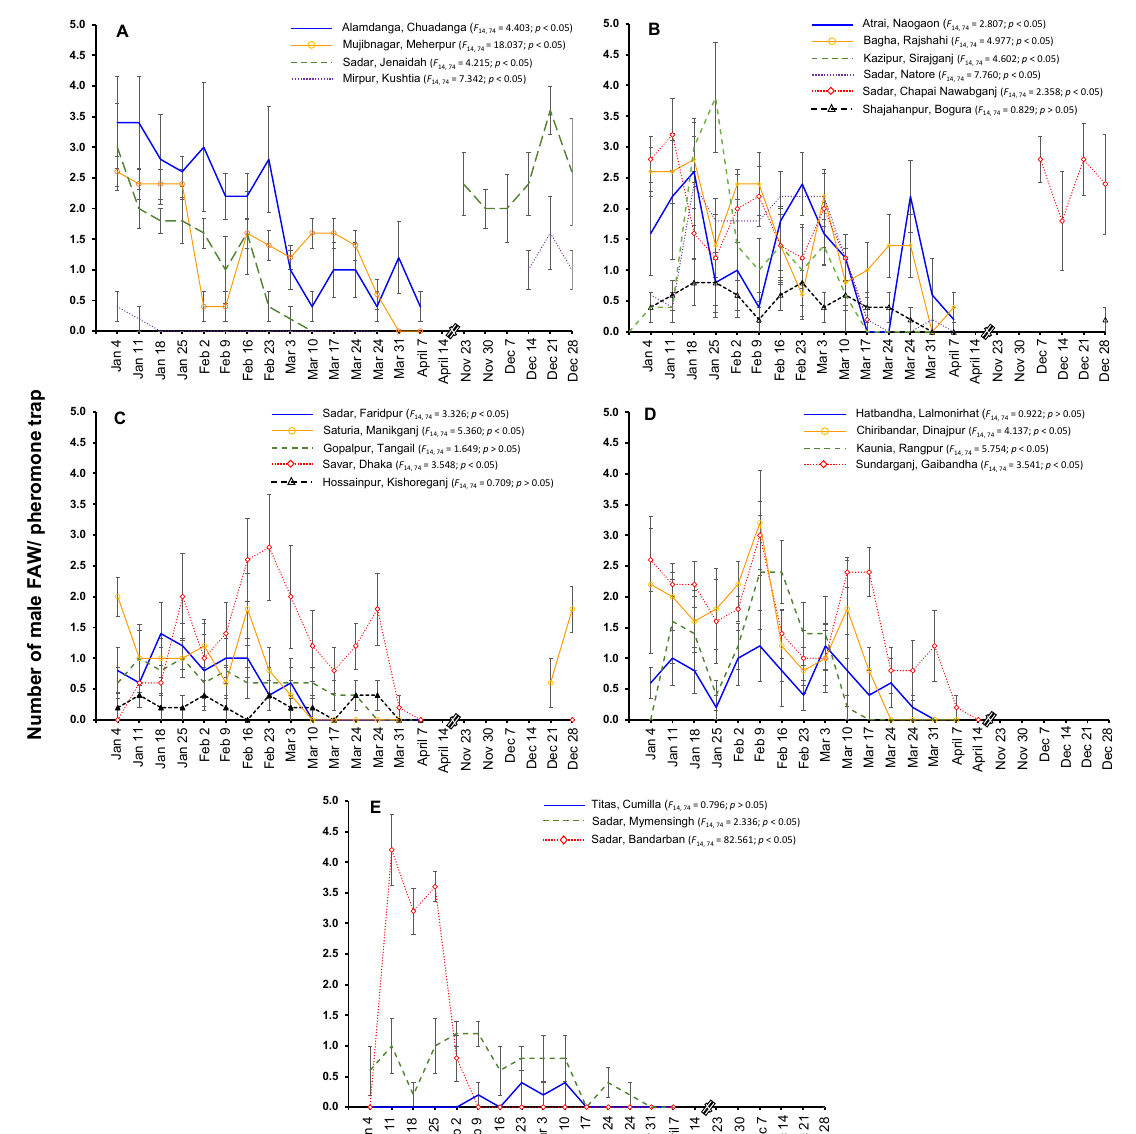
Figure 6. Numbers of fall armyworm adult male catches in pheromone traps in different districts in Bangladesh in maize fields. ( A ) Khulna division; ( B ) Rajshahi division; ( C ) Dhaka division; ( D ) Rangpur division; ( E ) Chattagram and Mymensingh divisions. Data are shown as mean ± SE. No adult FAW was trapped in two districts (Sherpur and Moulvibazar).